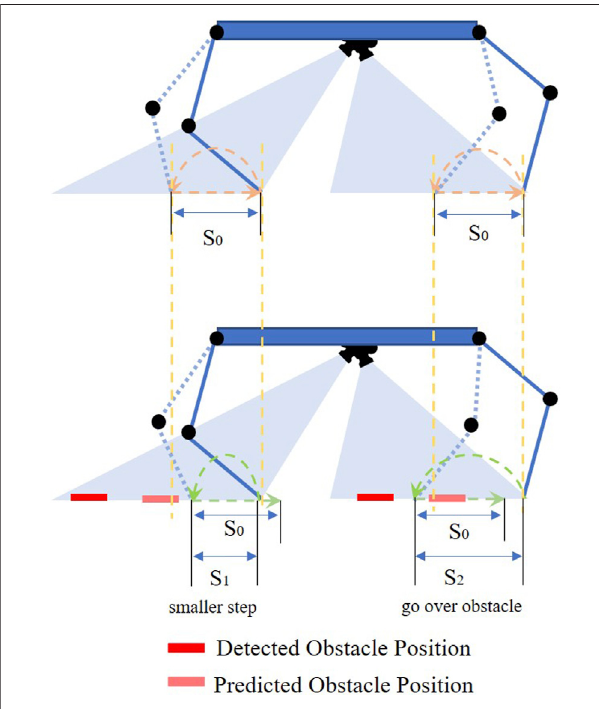
FIGURE 11 | In the camera-based autonomous obstacle avoidance gait, the computer modi fi es the default swing distance S 0 to a smaller swing distance S 1 orlargerswingdistance S 2 asneededtoavoidobstaclesshownin the bottom image. The stance distance (step length) is always the same as the default stance distance S 0 . The detected obstacle position is the observedpositionatthebeginningoftheswingphase, thepredicted obstacle position is where the obstacle will be relative to the robot at the end of the swing phase.